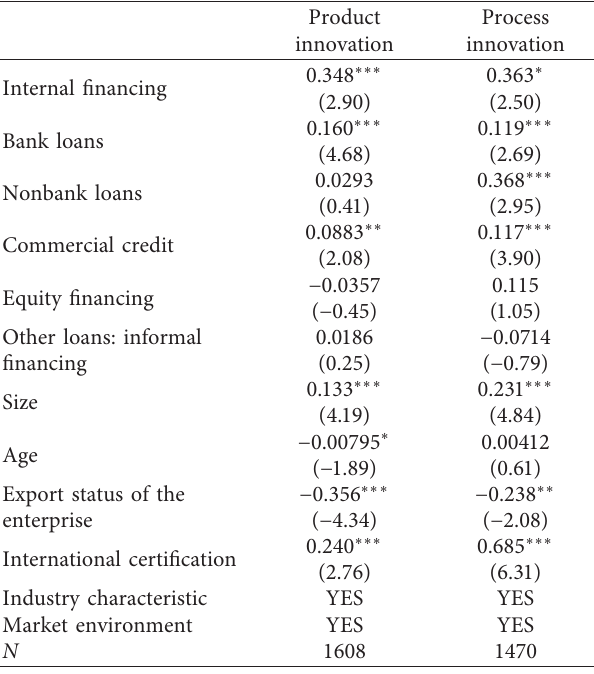
Table 6: Regression of financing methods to technological inno- vation behavior of private enterprises.